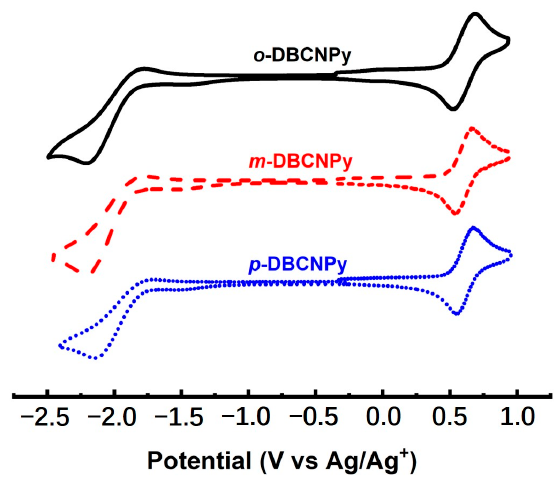
Figure 6. Cyclic voltammograms of the compounds; scan rate, 50 mV s − 1 . Table 3. Electrochemical data of the isomers.